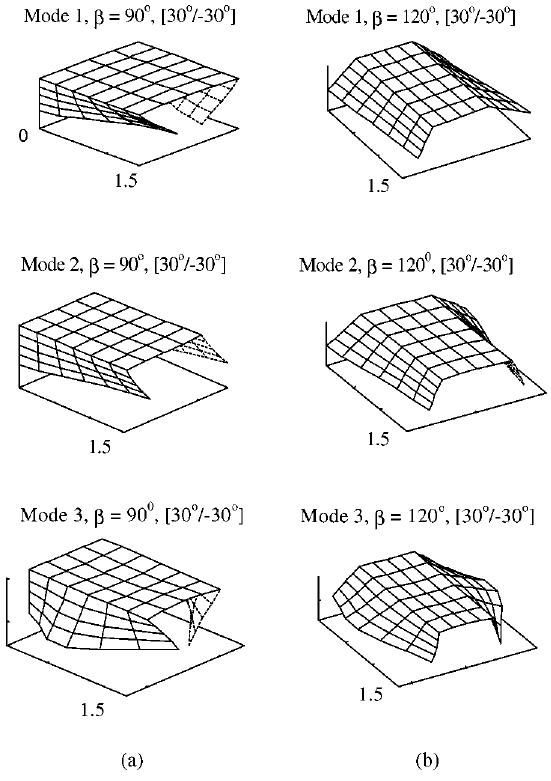
Fig. 5. First, second and third mode shapes of E-glass–Epoxy com- posite twofold folded plate with (a) crank angle (cid:12) = 90 (cid:14) , ply ar- rangement 30 (cid:14) = (cid:0) 30 (cid:14) , and (b) crank angle (cid:12) = 120 (cid:14) , ply arrange- ment 30 (cid:14) = (cid:0) 30 (cid:14) .